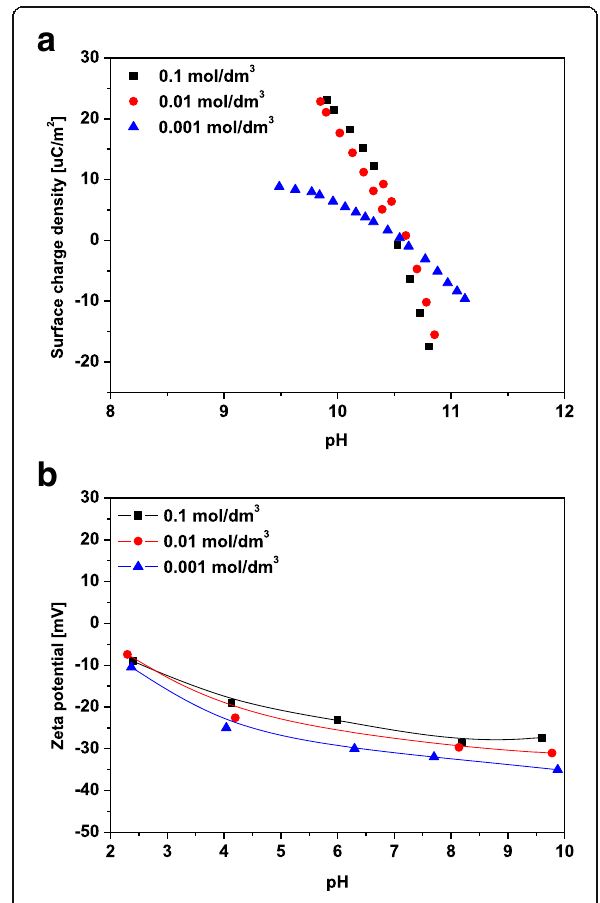
Fig. 10 a Surface charge of biochar in aqueous solution of NaCl as a function of pH and b diagram of biochar potential zeta dependence on pH value in aqueous NaCl